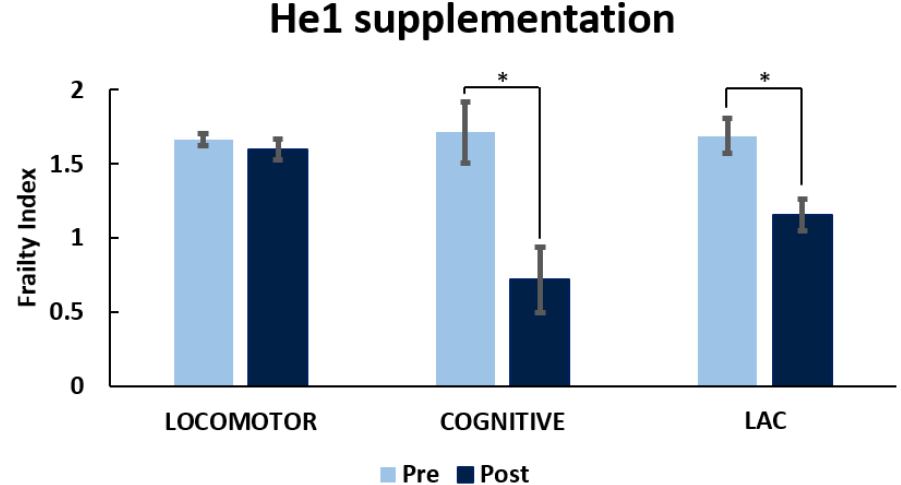
Figure 8. H. erinaceus improved recognition memory during mice aging. Value measured pre- supplementation (pre) and post-supplementation (post) on locomotor, recognition memory, and LAC (Locomotor And Cognitive) FI. p < 0.05